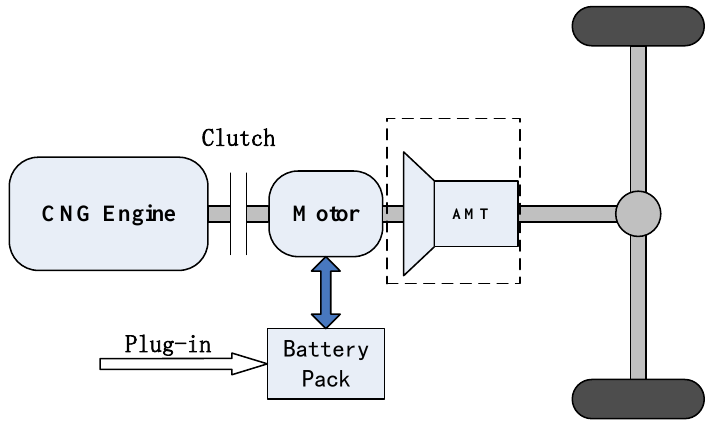
Figure 1. Configuration of the PHEV powertrain.